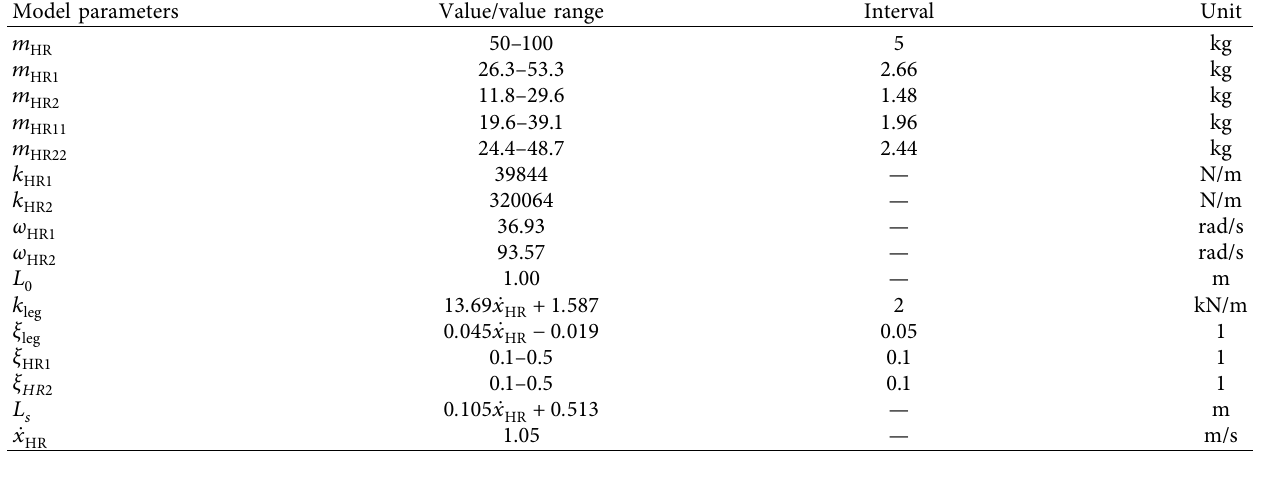
Table 2: Parameters and variable ranges of the bipedal walking model.